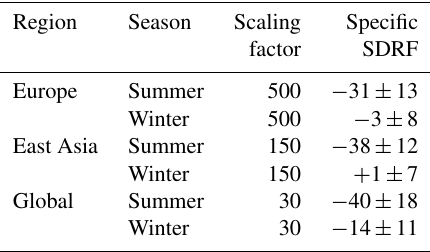
Table 6. Semi-direct radiative forcing (SDRF) by regional and sea- sonal perturbations of black carbon aerosols. Column 3 gives the scaling factor imposed to let rapid adjustments from the semi-direct effect emerge from natural variability. Column 4 gives the corre- dard deviation over the 30